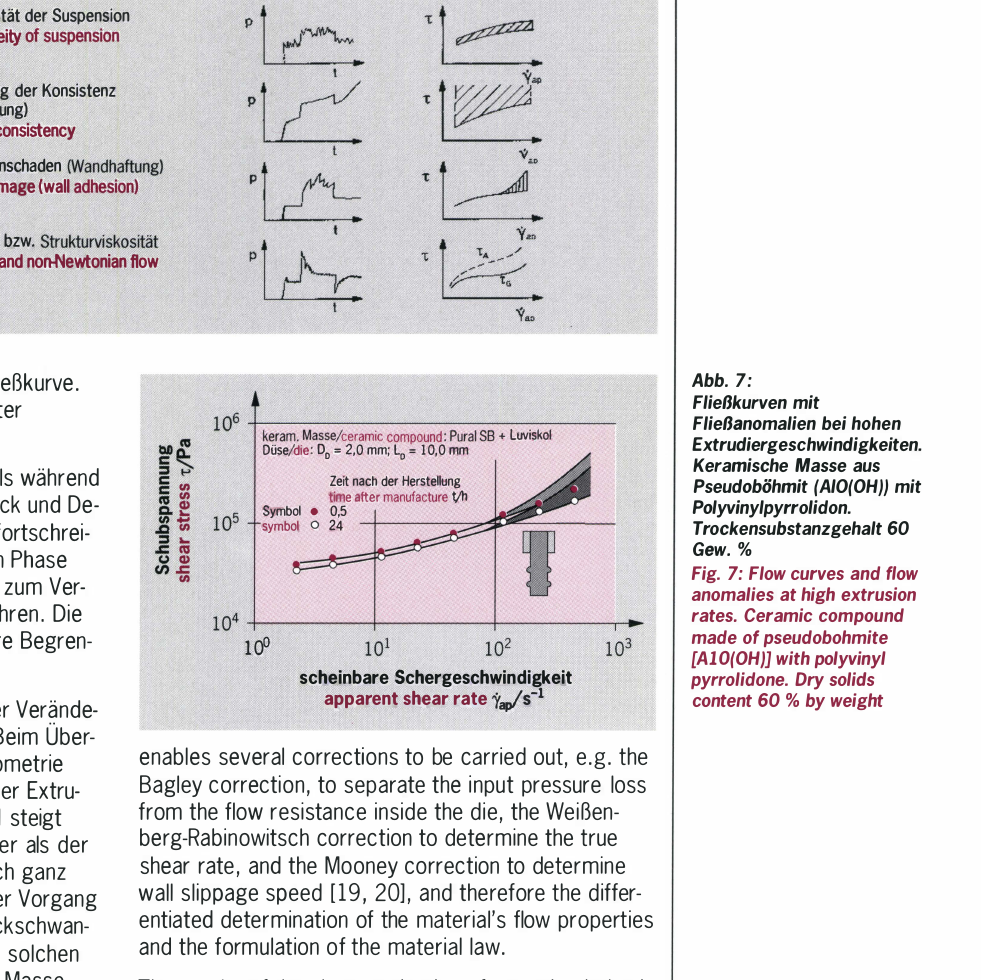
I lnhomogenitat der Suspension Inhomogeneity of suspension II Veranderung der Konsistenz (Entwasserung) Fig. 6: Change in consistency Characteristic phenomena during extrusion. Pressure­